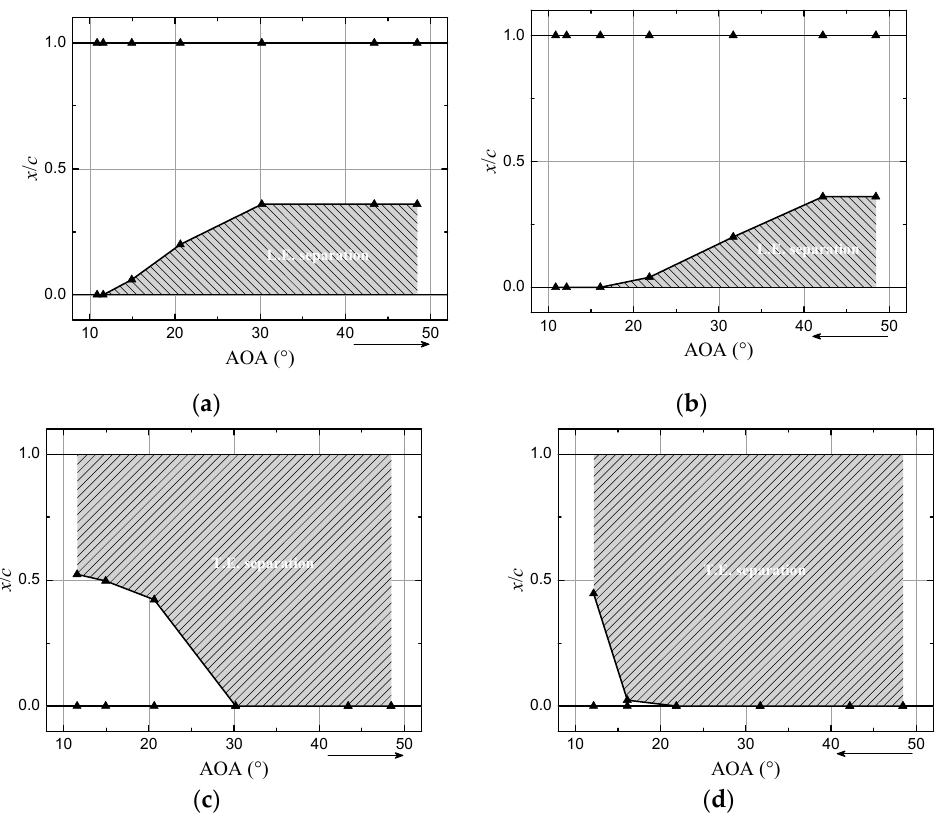
Figure 18. Comparison of flow separation and reattachment between the blade section and airfoil. r / R = 30%, V w = 15 m/s, and ϕ y = 30°. ( a ) 3D blade flow with increasing AOA; ( b ) 3D blade flow with decreasing AOA; ( c ) 2D airfoil flow with increasing AOA; ( d ) 2D airfoil flow with decreasing